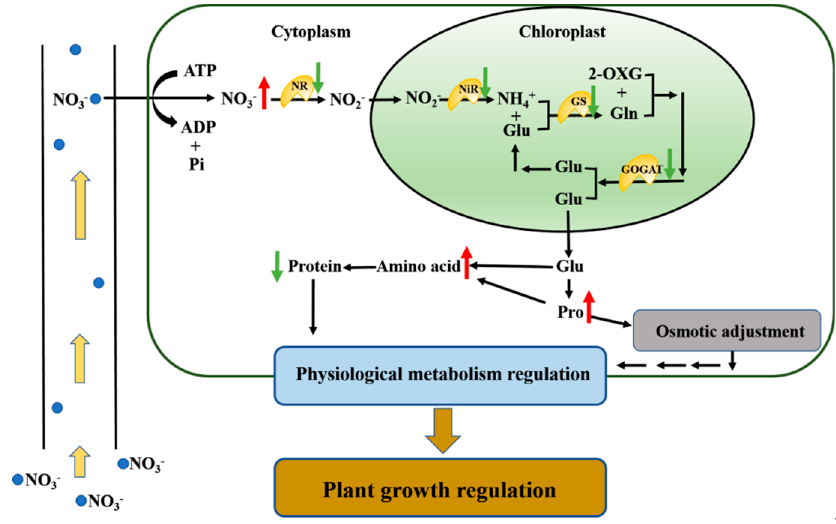
Figure 6. A model of the nitrogen regulation in soybean leaf in response to drought stress. Here, drought stress triggers a nitrogen-mediated tandem reaction in response to drought stress. Drought stress might change the expression of key regulatory metabolic genes and the activities of nitrogen metabolism enzymes, which regulate nitrogen distribution and utilization to adapt to environmental stress. NR, nitrate reductase; NiR, nitrite reductase; GS, glutamine synthetase; GOGAT, glutamate synthetase; Glu, glutamate; Gln, glutamine; 2-OXG, 2-oxoglutarate. Increased items under drought stress are marked with upward red arrows and decreased items are marked with downward green arrows.